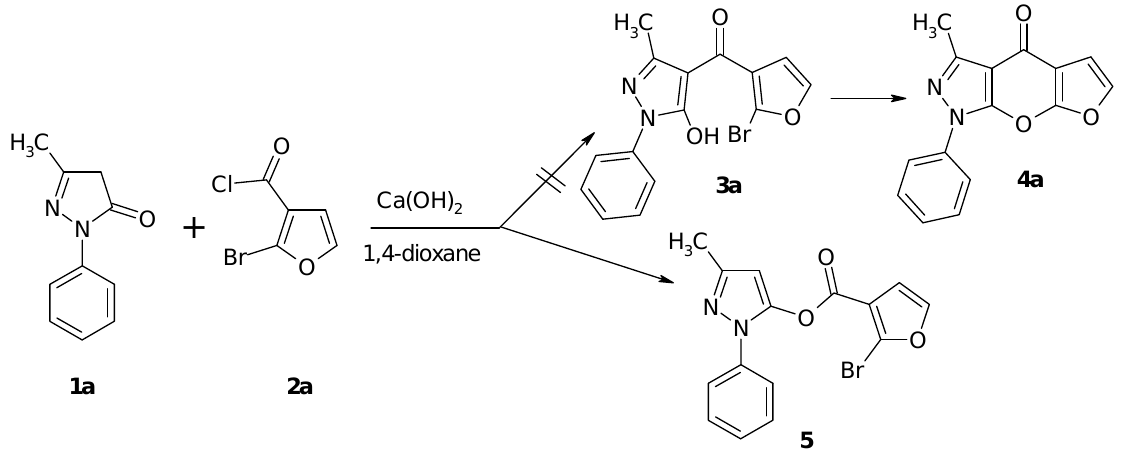
Scheme 2. Reaction of 1a and 2a under ‘ Jensen